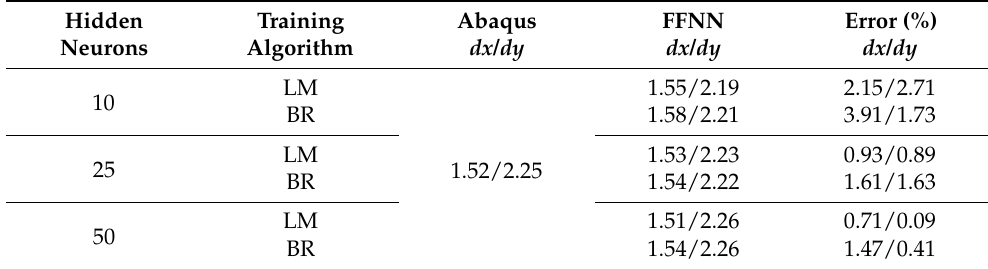
Table 6. Comparison between NN and FEM results of FFNN1.